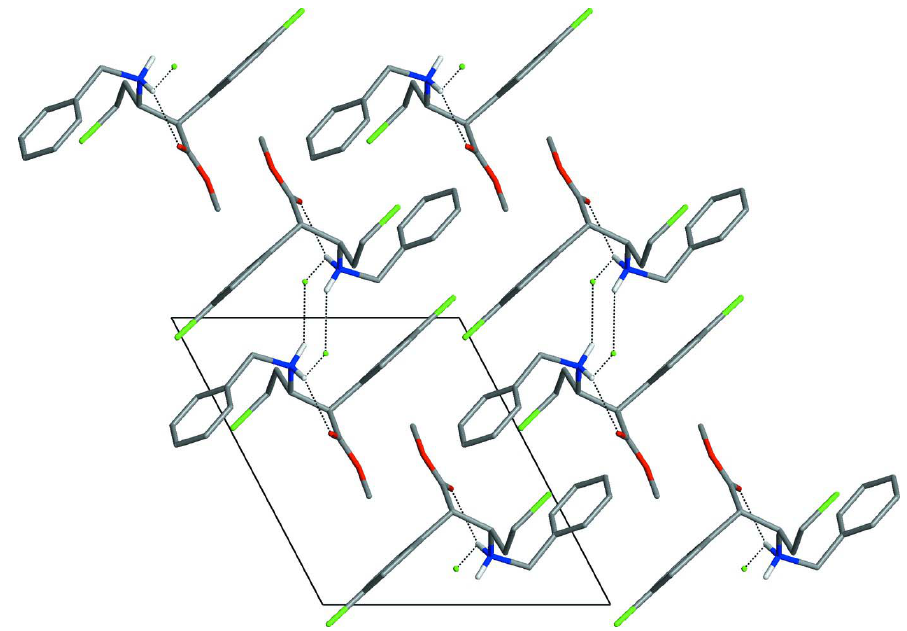
Figure 2 Molecular packing and unit cell of (I) viewed along the a axis. Hydrogen bonding is indicated by dashed lines, H-atoms bonded to C have been omitted for